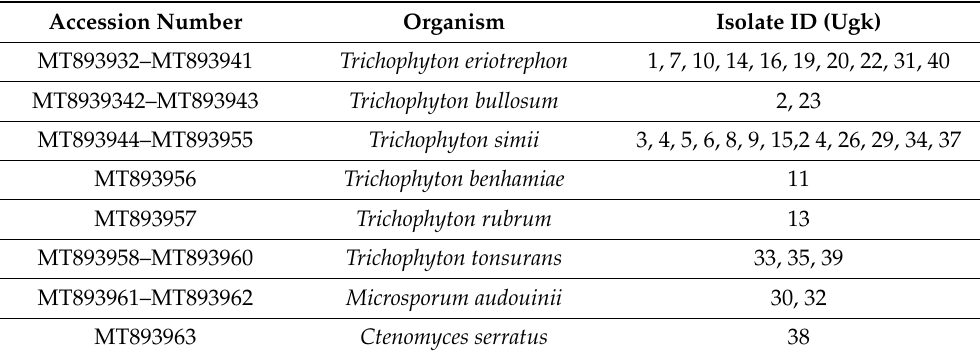
Table 1. Clinical strains and accession number of dermatophytes used in this